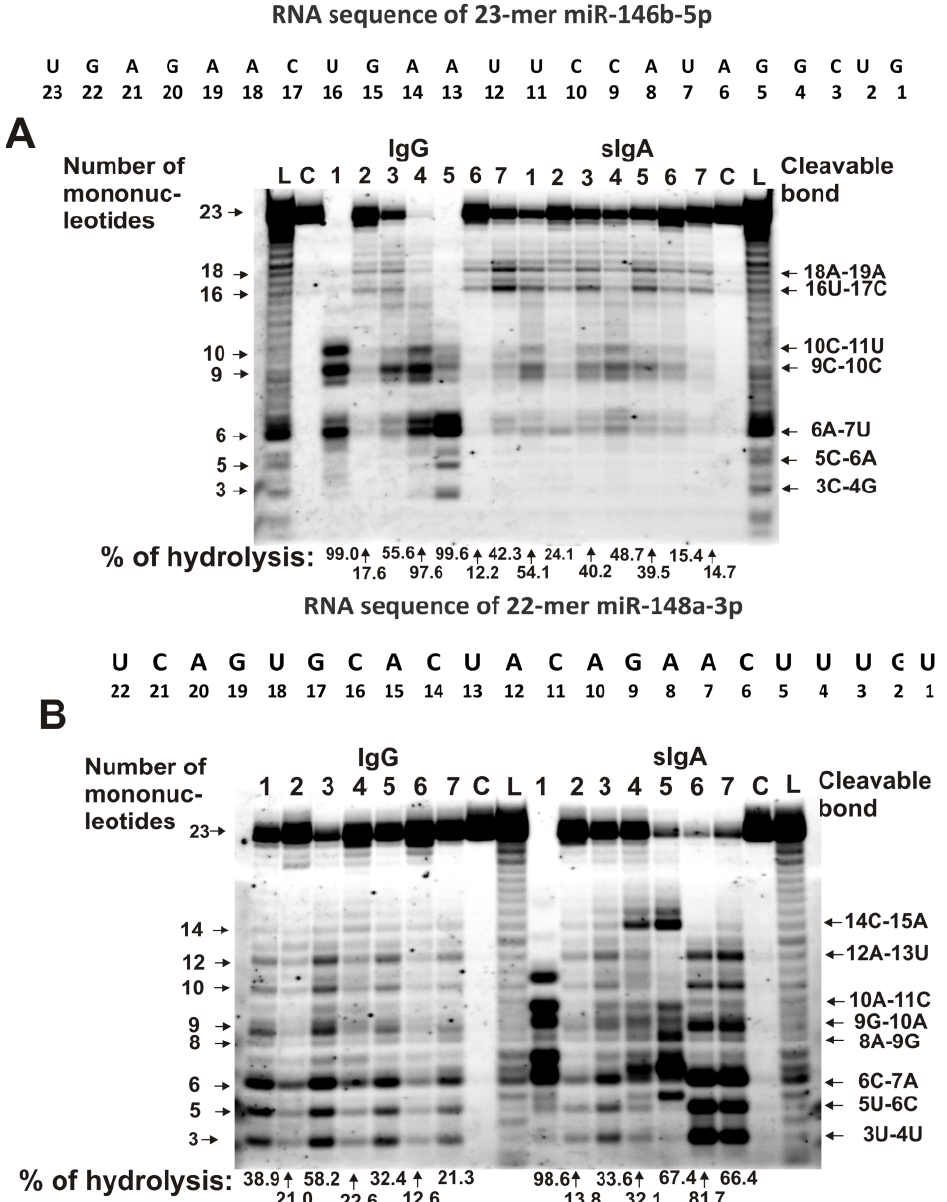
Figure 1. The patterns of 0.01 mg/mL Flu- miR-146b-5p ( A ) and Flu- miR-148a-3p ( B ) hydrolysis by sIgAs and IgGs (0.04 mg/mL) from human milk plasma. The hydrolysis products were detected due to the fluorescent residue (Flu) on microRNAs’ 5 ′ -ends after reaction mixture incubation for 1 h. The numbers of sIgAs and IgGs, lengths of the splitting products, and the percentages of hydrolysis of two microRNAs by each antibody preparation, are indicated in panels ( A , B ).